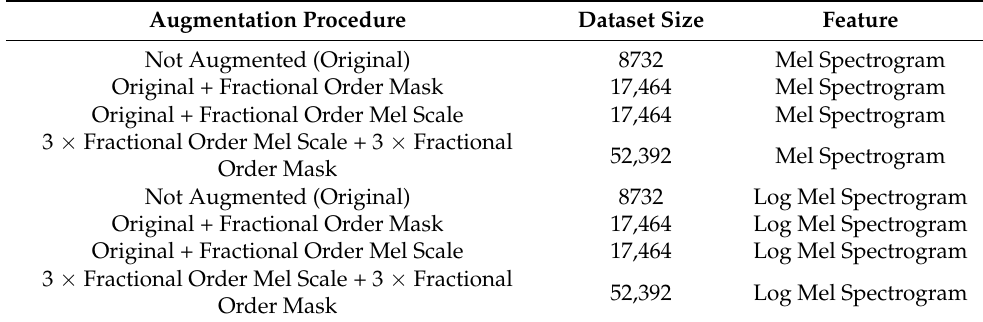
Table 2. Dataset sizes for each